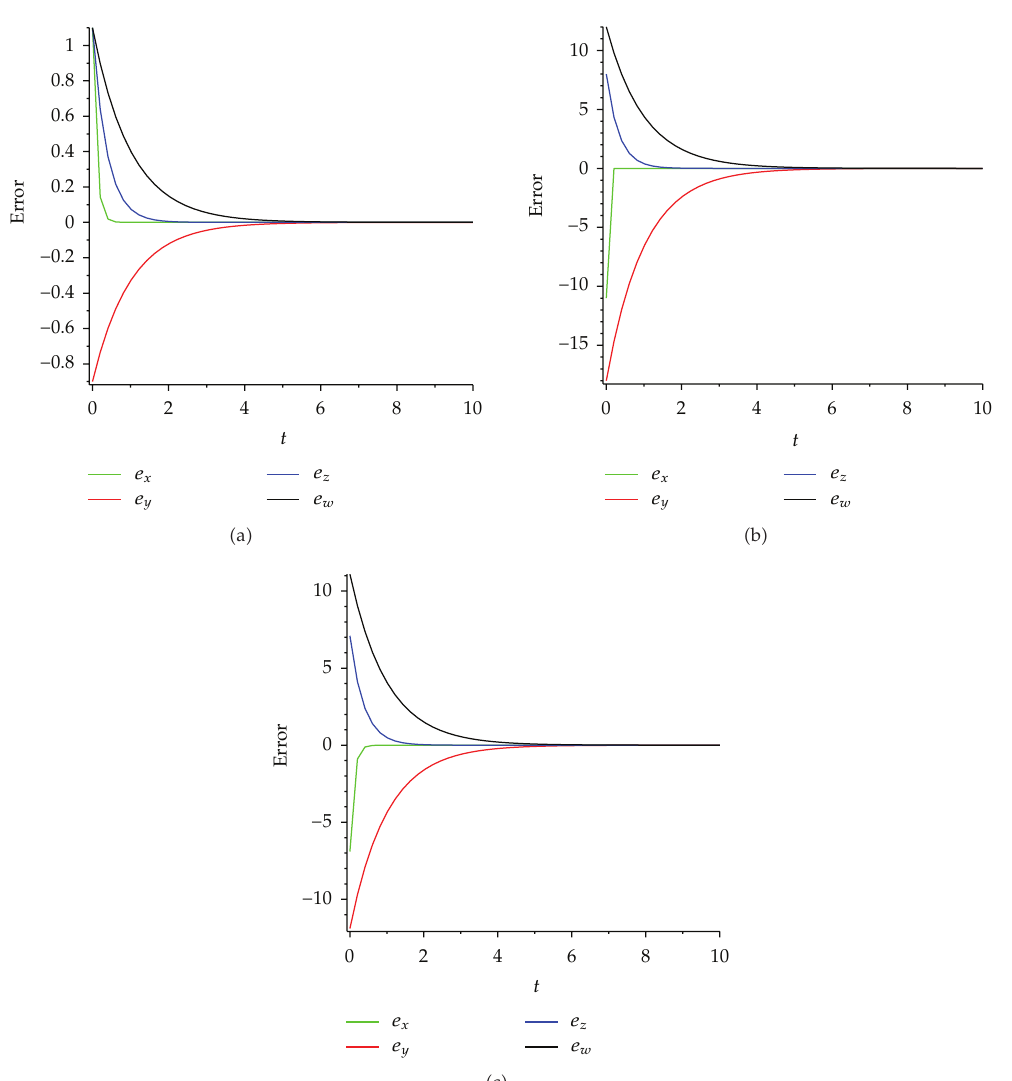
and e w (cid:6) t (cid:7) tended to zero after t ≥ 5. Figure 14 shows the evaluation of the ratios log | x 2 /x 1 | , log | y 2 /y 1 | , log | z 2 /z 1 | , and log | w 2 /w 1 | whose limits are equal to log 5 (cid:8) 1 .